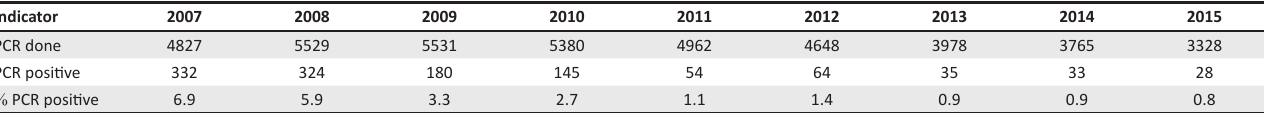
TABLE 4: Human immunodeficiency virus polymerase chain reaction testing of infants exposed to human immunodeficiency virus at around 6 weeks of age in the 13 healthcare facilities in Soweto, 2007–2015.